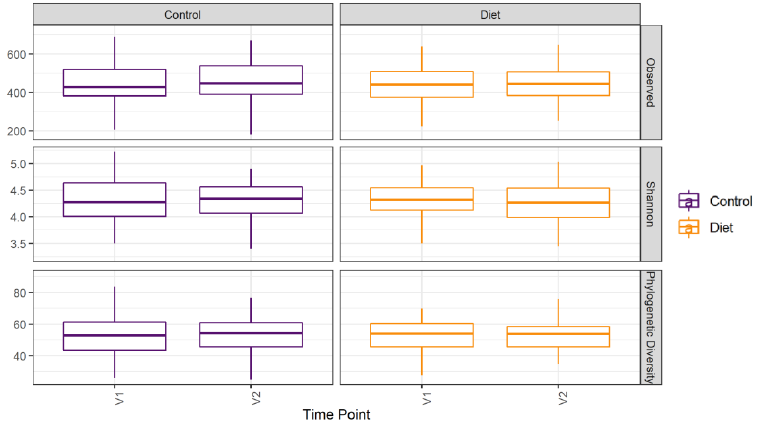
Figure 3. Microbiota alpha diversity was not affected by increasing protein intake. Alpha diversity for the control and diet groups at baseline (V1) and 6 month follow-up (V2) based on observed number of taxa, Shannon index, and Faith’s Phylogenetic Diversity index. Observed taxa is the total number of unique ASVs observed in a sample; it is a metric for richness. Shannon is an evenness diversity metric: a more even distribution results in a higher diversity. FPD takes into account the phylogeny of the observed taxa; it is a metric for genetic diversity. Linear mixed models were used to test for intervention-induced changes in alpha diversity. In these models an interaction term for intervention × time and a random intercept for participant were included. Dietary advice aimed at increasing protein intake did not affect any of the alpha-diversity measures. ASV: amplicon sequence variants; FPD: Faiths Phylogenetic Diversity.